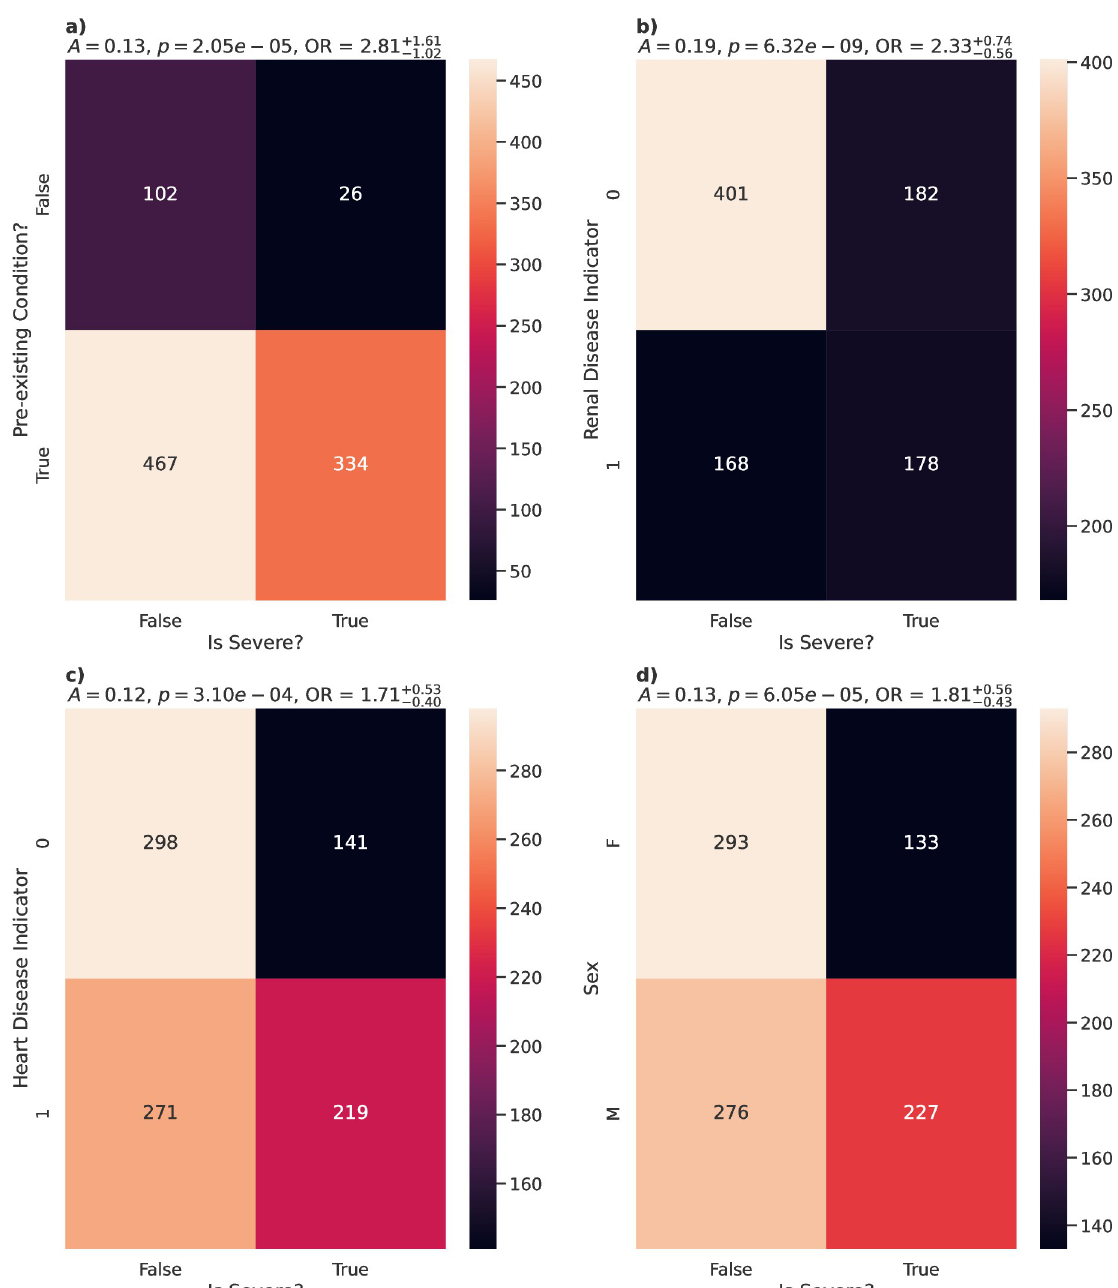
Fig 2. Association of disease severity with discrete variables. Heatmaps comparing the counts between severe cases (death, ICU admission or intubation) and non-severe cases for a selection of categorical features with statistically significant relationships with disease severity. Variables shown are a) the presence of existing conditions, b) whether the patient suffers from renal disease, c) whether the patient suffers from heart disease and d) sex at birth. Association strength A (based on Cramer’s V), p-values p , and odds ratio between the classes are shown above each